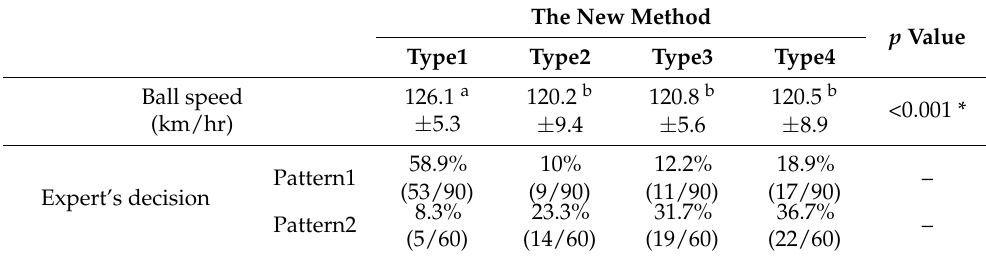
Figure 5. Four types of pelvic and trunk rotational pitching mechanics (viewing in the transverse plane). A “PAoFC” (Pelvic angle at the moment of foot contact) of − 70° and “TPSoFC” (Trunk-pelvis separation at the moment of foot contact) of − 25° were used for classification based on the result of the cut-off values from ROC (receiver operating characteristic). Type1 (proper mechanics) represents a leading “PAoFC” and is followed by the trunk with enough separation between the pelvis and trunk. Type2 (early trunk rotation) represents a leading “PAoFC” and is followed by the trunk with insufficient separation between the pelvis and trunk. Type3 (delayed pelvic rotation) represents a fallen behind “PAoFC” and is followed by the trunk with insufficient separation between the pelvis and trunk. Type4 (delayed pelvic rotation with trunk turning-back) represents a fallen behind “PAoFC” and is followed by the trunk with enough separation between the pelvis and trunk. Typically, the adequate separation of Type4 results from a turning-back of trunk rotation prior to foot contact. Types 2–4 are regarded as being characterized by “improper mechanics”. Table 5. Ball speed and pitch count percentage of different types using the new